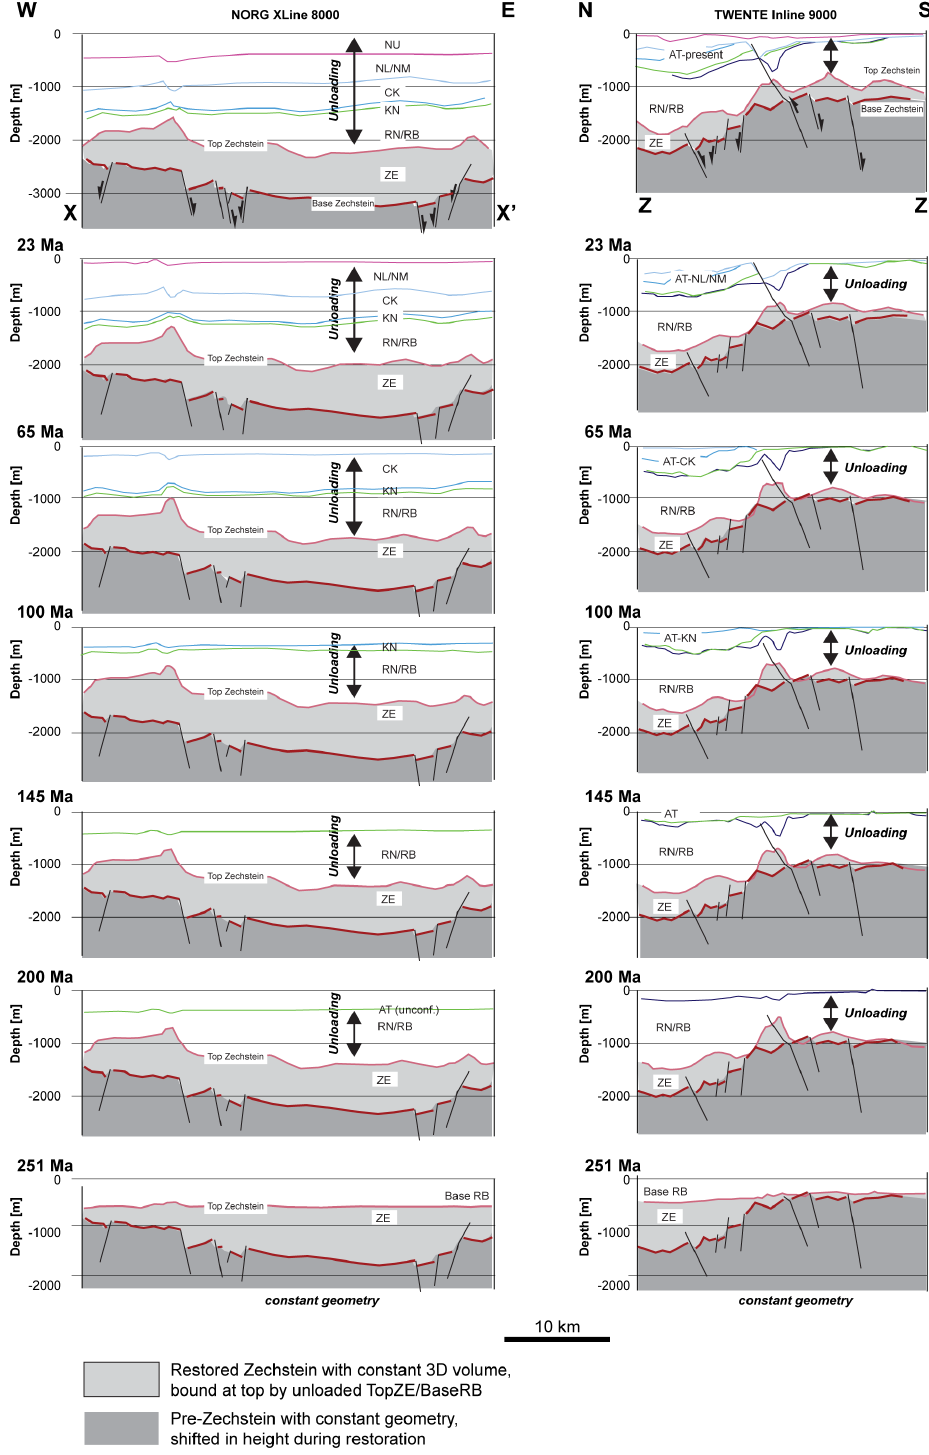
Figure 5. Restoration examples (scenario 2 – unloading and decompaction). Selected geological sections ( X – X (cid:48) : NORG XL 8000; Z – Z (cid:48) : TWENTE IL 9000) through the 3D model that illustrate the sequential evolution of structure, stratigraphy and thickness of the Zechstein unit. Note absence of Jurassic strata (AT unconformity) along cross section X – X (cid:48) . Also note pronounced flattening of top salt towards 251Ma. For illustration of 3D salt-thickness change and 3D subsurface salt flow through time, see Figs. 6 to 8. For location of sections, see Figs. 2 and